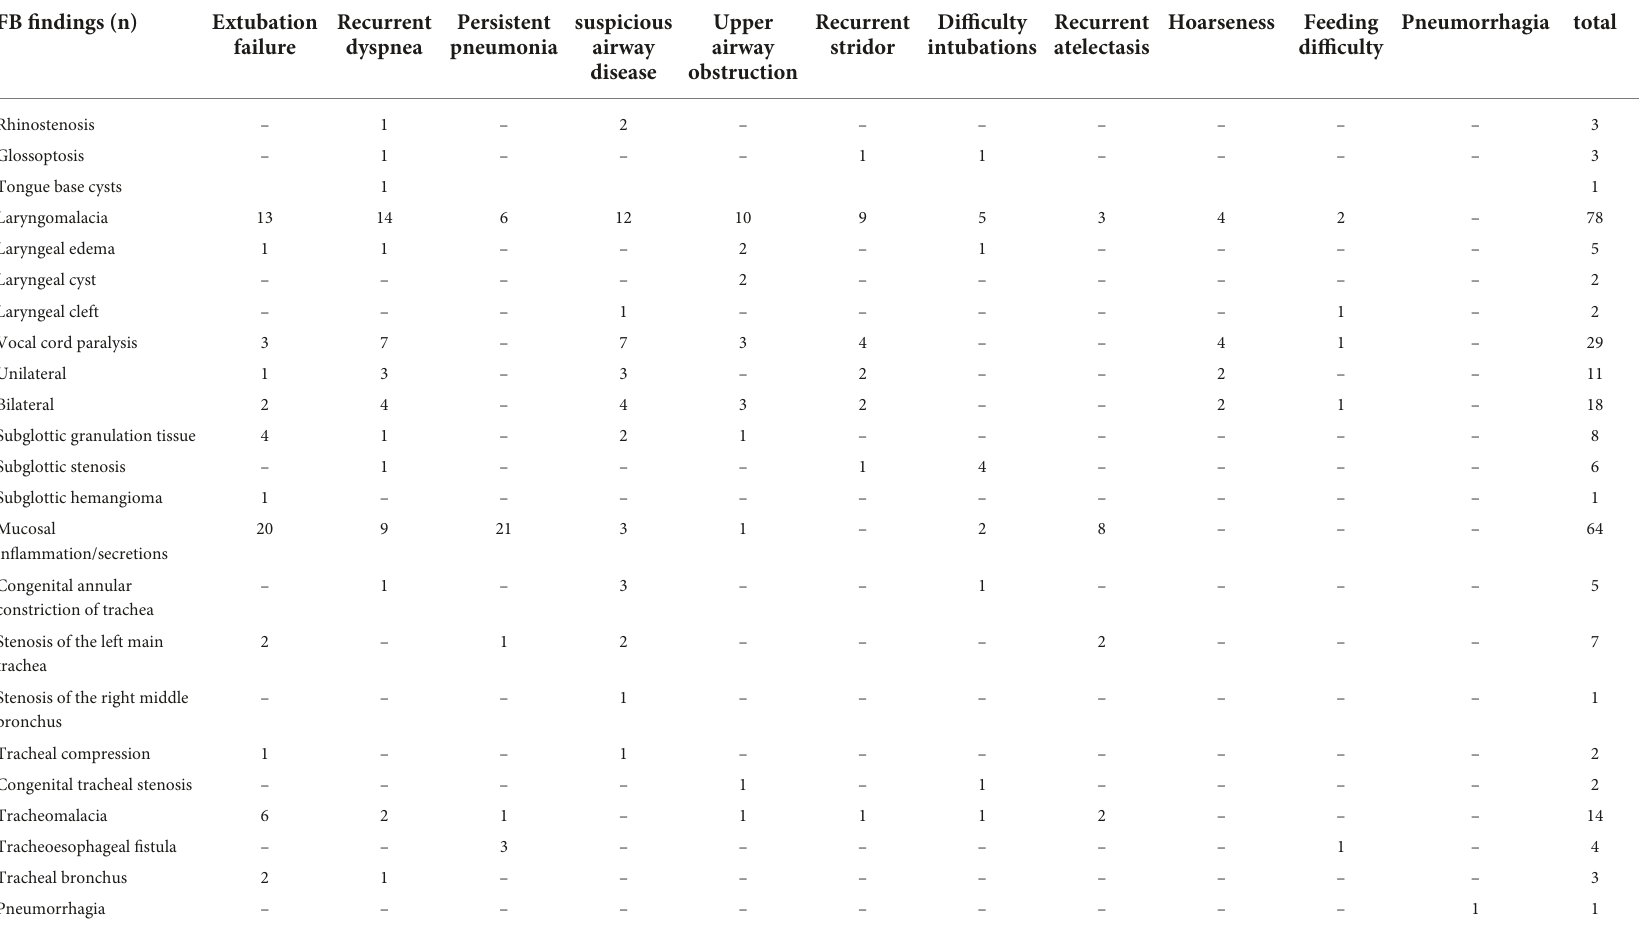
TABLE 3 The indications and findings of